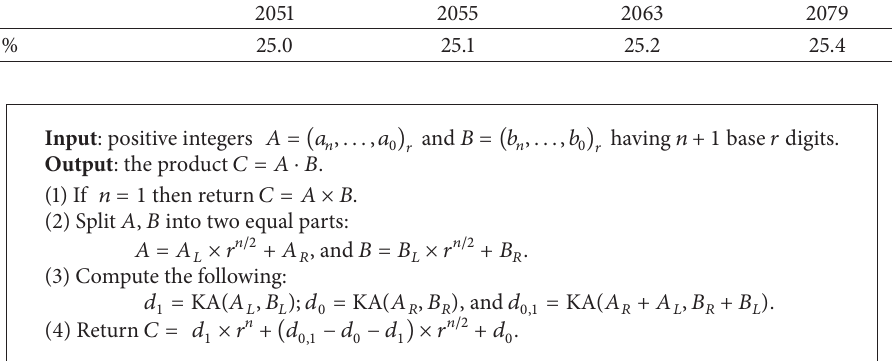
Algorithm 4: Recursive Karatsuba algorithm, 𝐶 = KA (𝐴, 𝐵) .